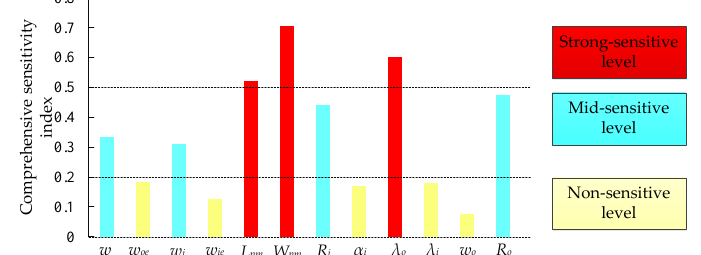
Figure 7. Sensitivity analysis for design